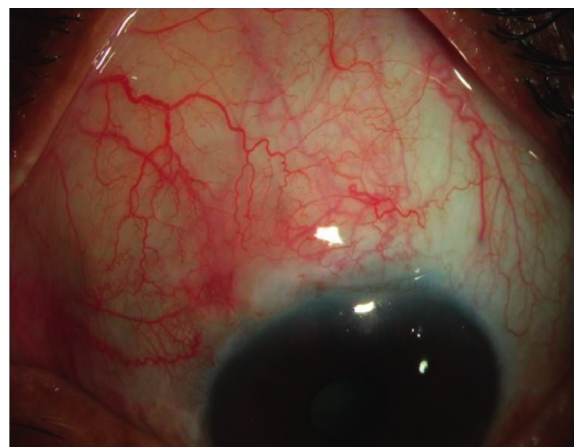
Figure 4: A diffuse slit-lamp image of a patient from Group I at one year of follow-up.